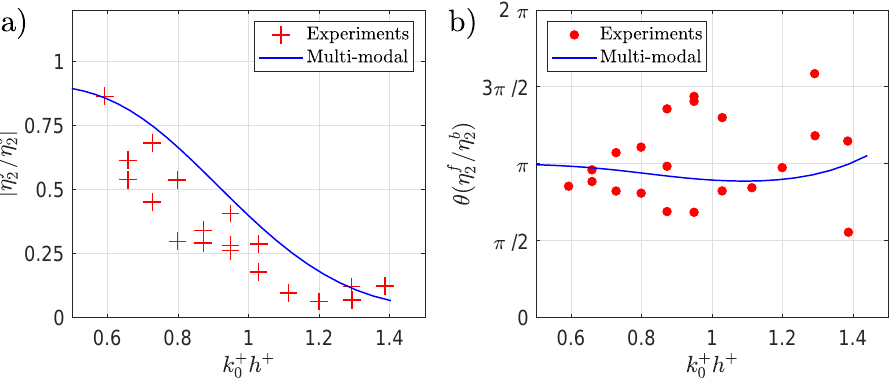
Figure 15. Experimental measurement and theoretical model of the second-order free and bound waves. ( a ) Amplitude ratio between free and bound waves measured at the step position θ ( η f